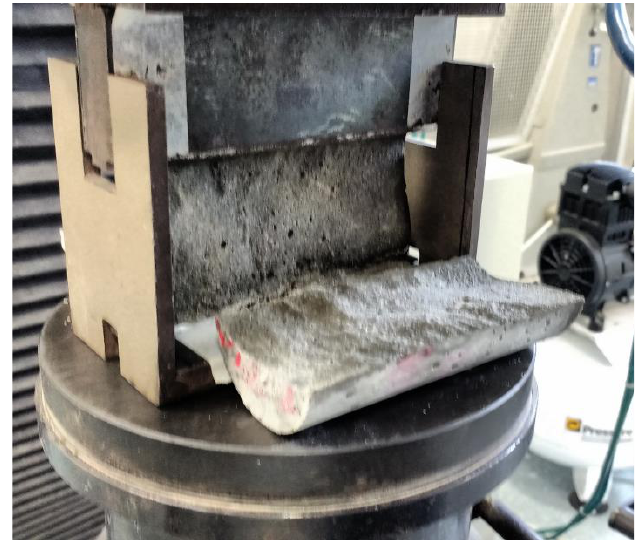
Figure 5. Splitting tensile strength test setup.